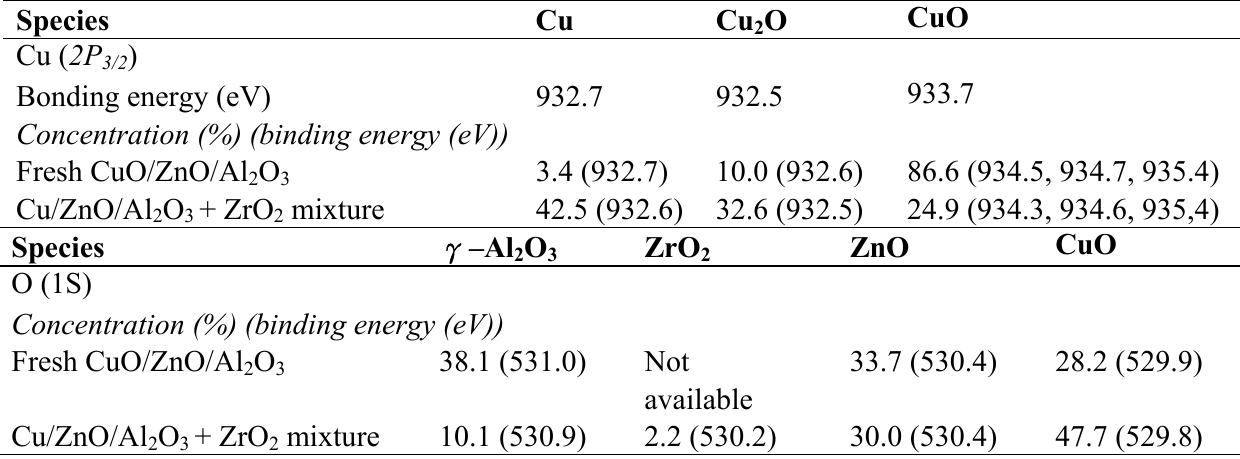
O washcoat catalysts determined using XPS 2 3